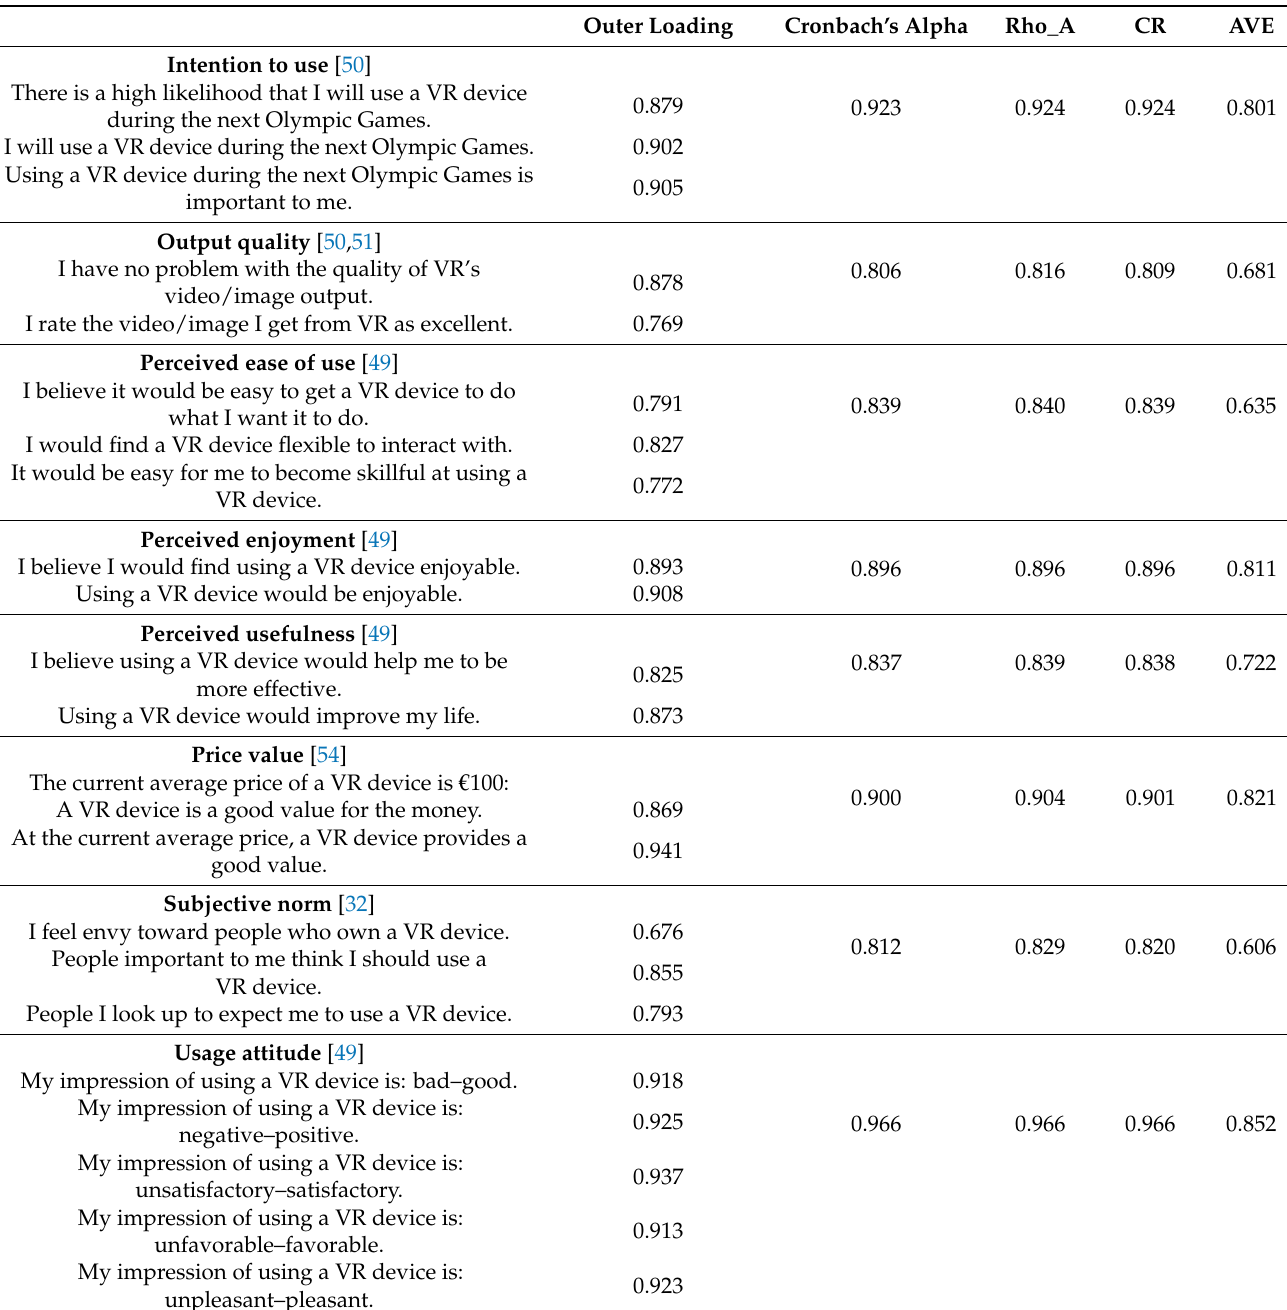
Outer Loading Cronbach’s Alpha Rho_A CR